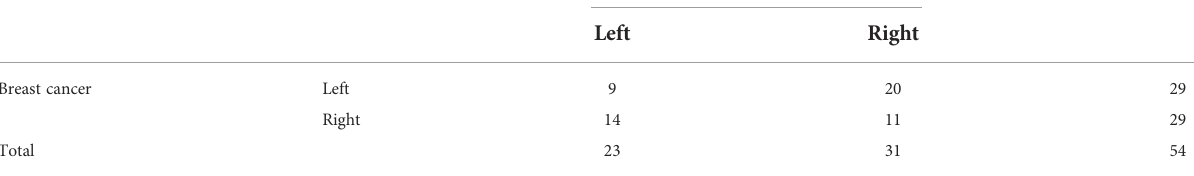
TABLE 4 Site of spontaneous breast and lung cancer lesions. No.